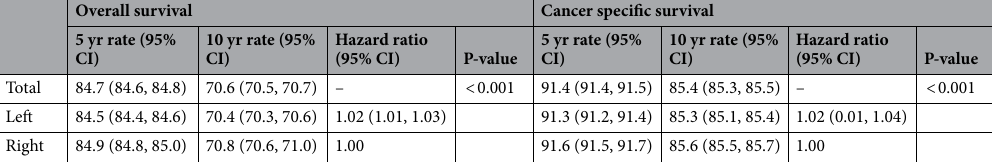
Table 3. Overall survival and cancer-specific survival rates in left and right breast cancer. Yr year, CI confidence interval.